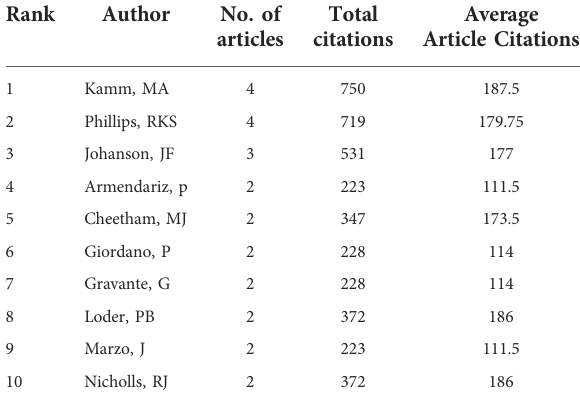
TABLE 4 The top 10 most-in fl uential authors.